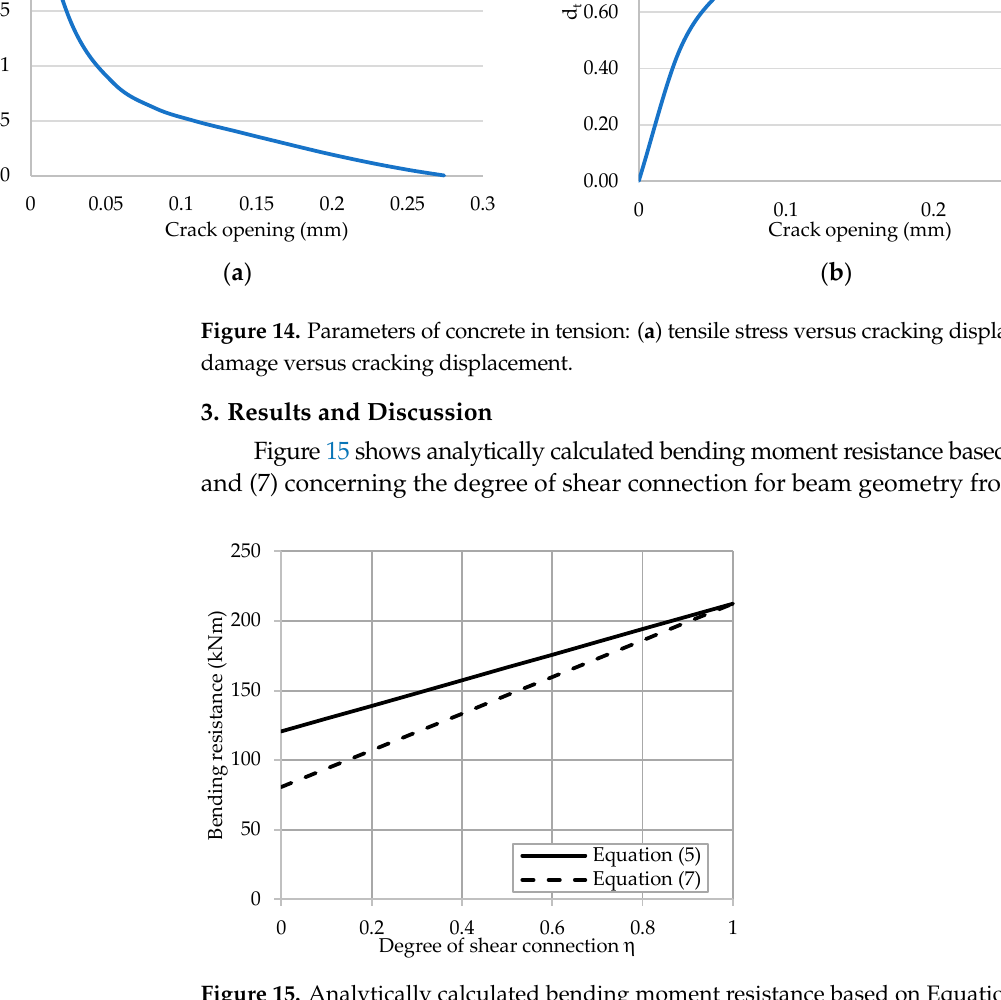
Figure 15. Analytically calculated bending moment resistance based on Equations (5) and (7) concerning the degree of shear connection.